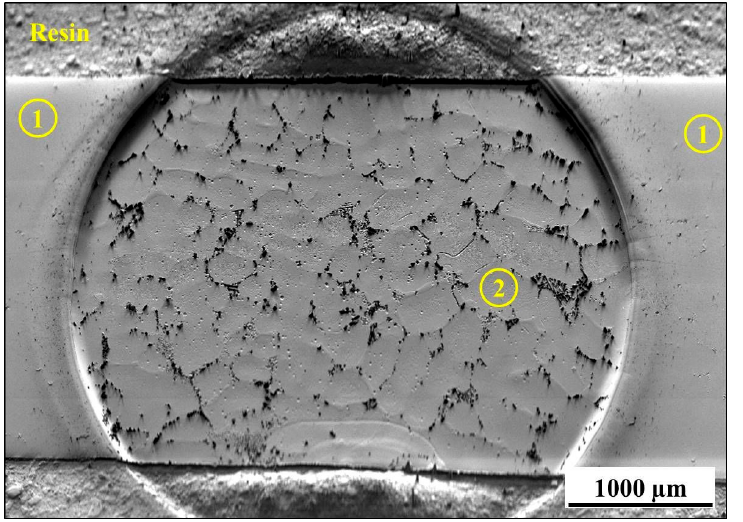
Figure 11. SEM/BSE image of plasma-etched cross-section of CM247 after air oxidation at 1050 °C for 20 h. Region 1 describes the original surface of the cross-section while region 2 shows the plasma-etched region (GD-OES crater bottom).